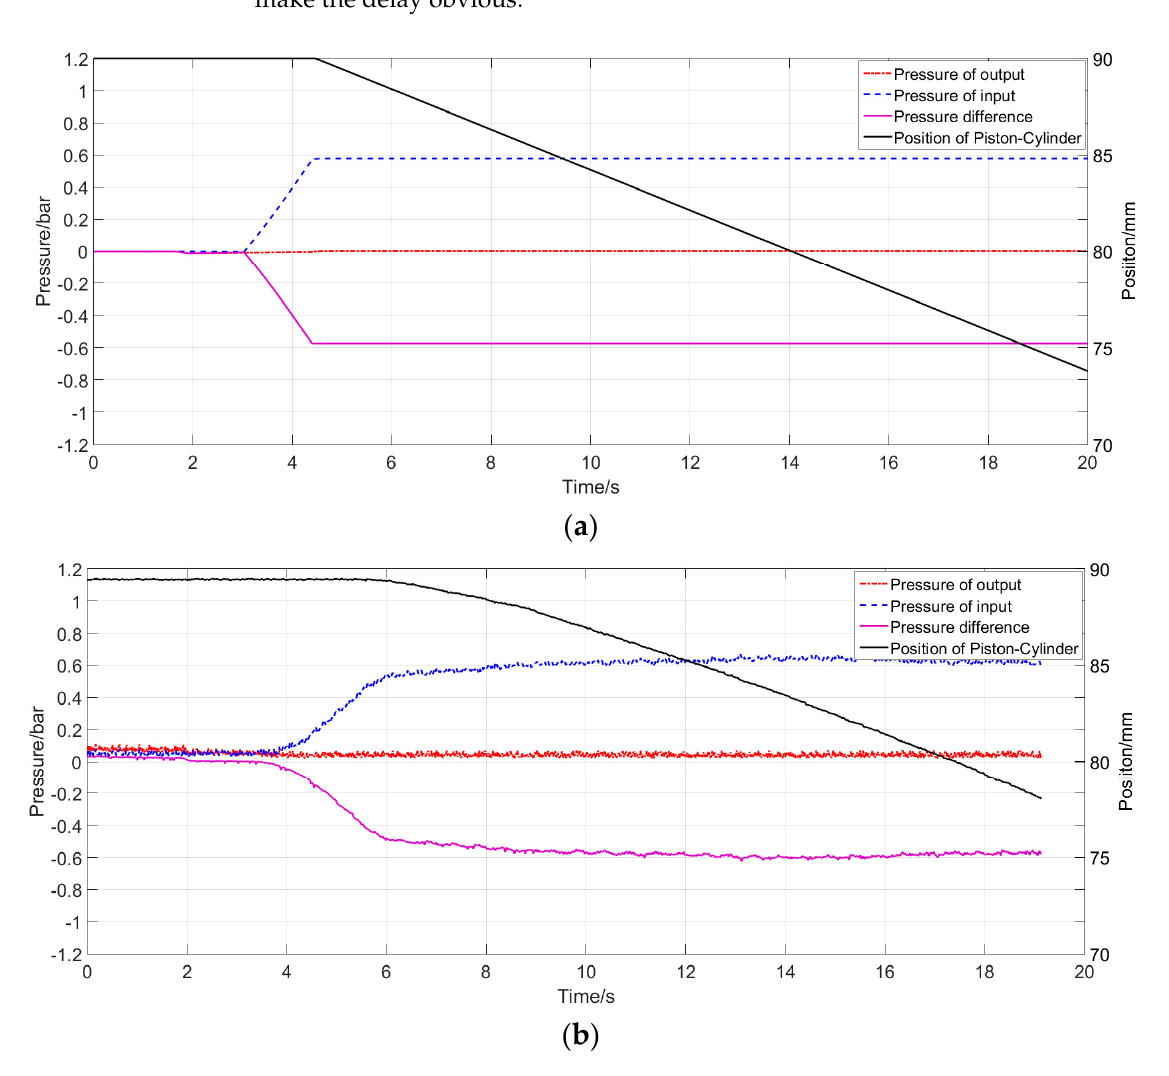
Figure 19. The simulation and the experimental results of position and pressure when pump speed is 20 RPM. ( a ) simulation results. ( b ) experimental results.